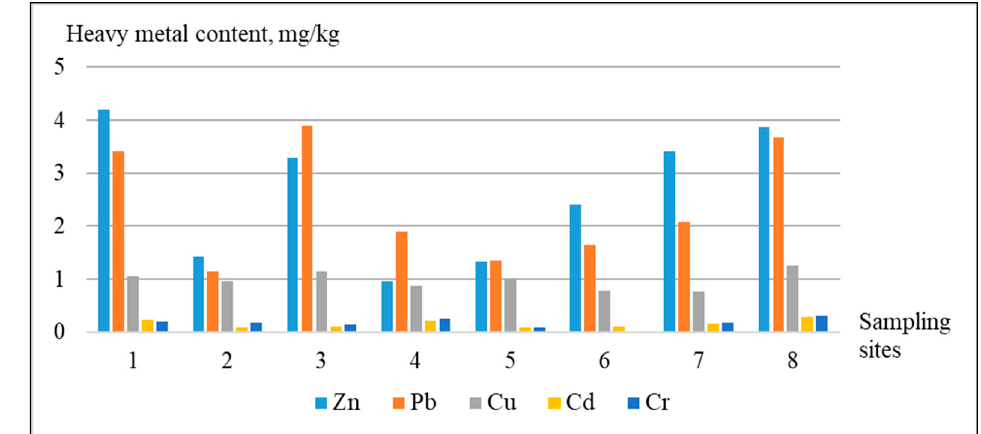
Figure 3. The content of heavy metals in the apple samples.